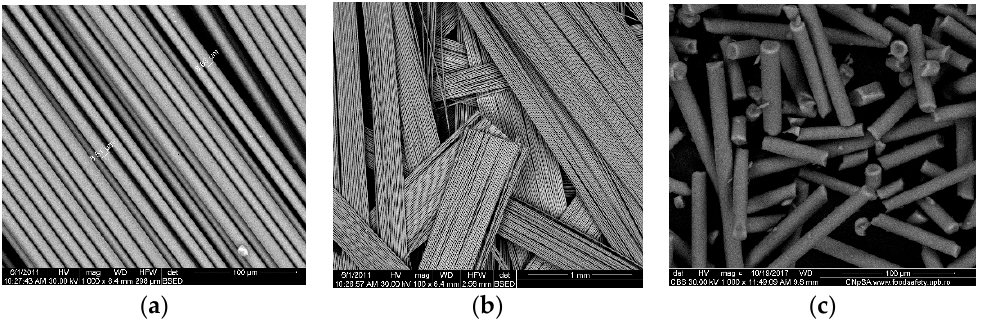
Figure 1. SEM images for: Optical fibers: Fabrics ( a ) and ( b ); optical fiber after cutting ( c ).